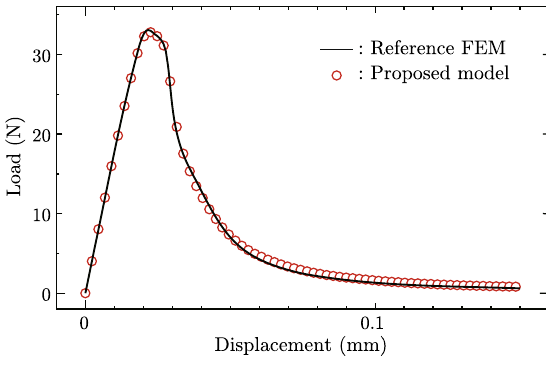
Fig. 9 Comparison of load–displacement curves in 2D beam problem